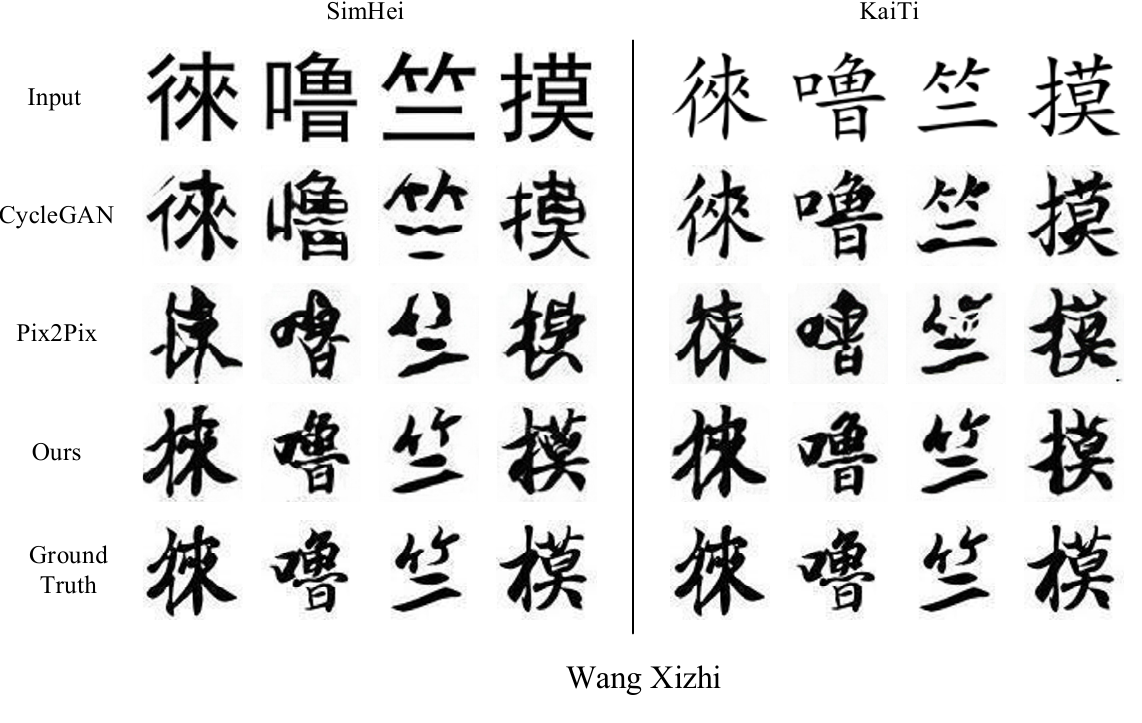
Figure 6. Generated results on the Wang Xizhi subset when using KaiTi and SimHei characters as input. Table 3. Quantitative evaluation of the impact of input font on the model.